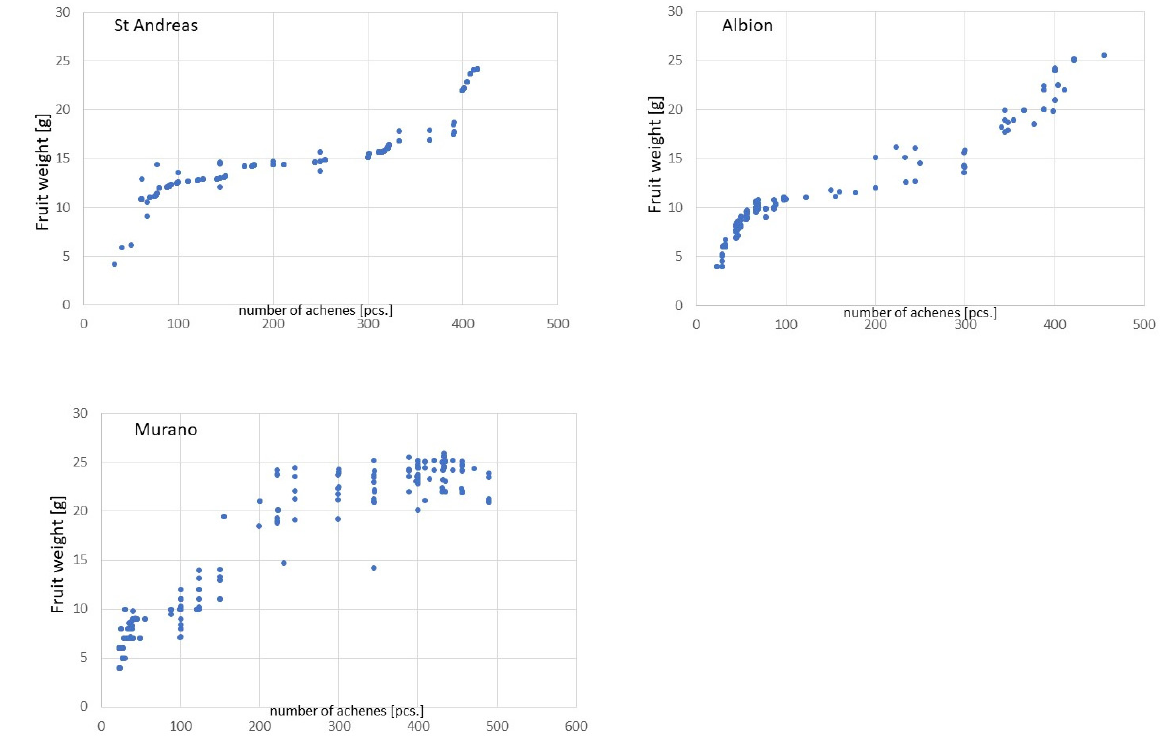
Figure 3. Relationship between the number of achenes and the weight of strawberry fruit.